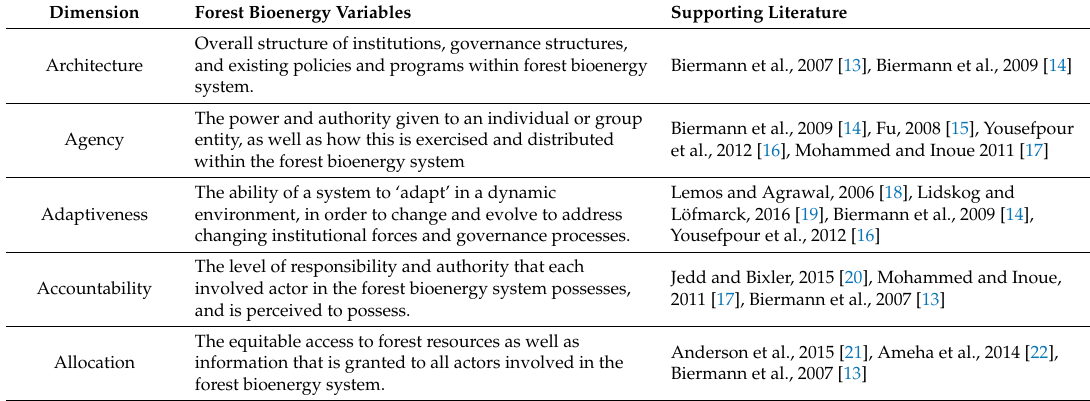
Table 1. Summary of Earth System Governance and Definitions, adapted from Biermann et al., (2007) [13]. Dimension Forest Bioenergy